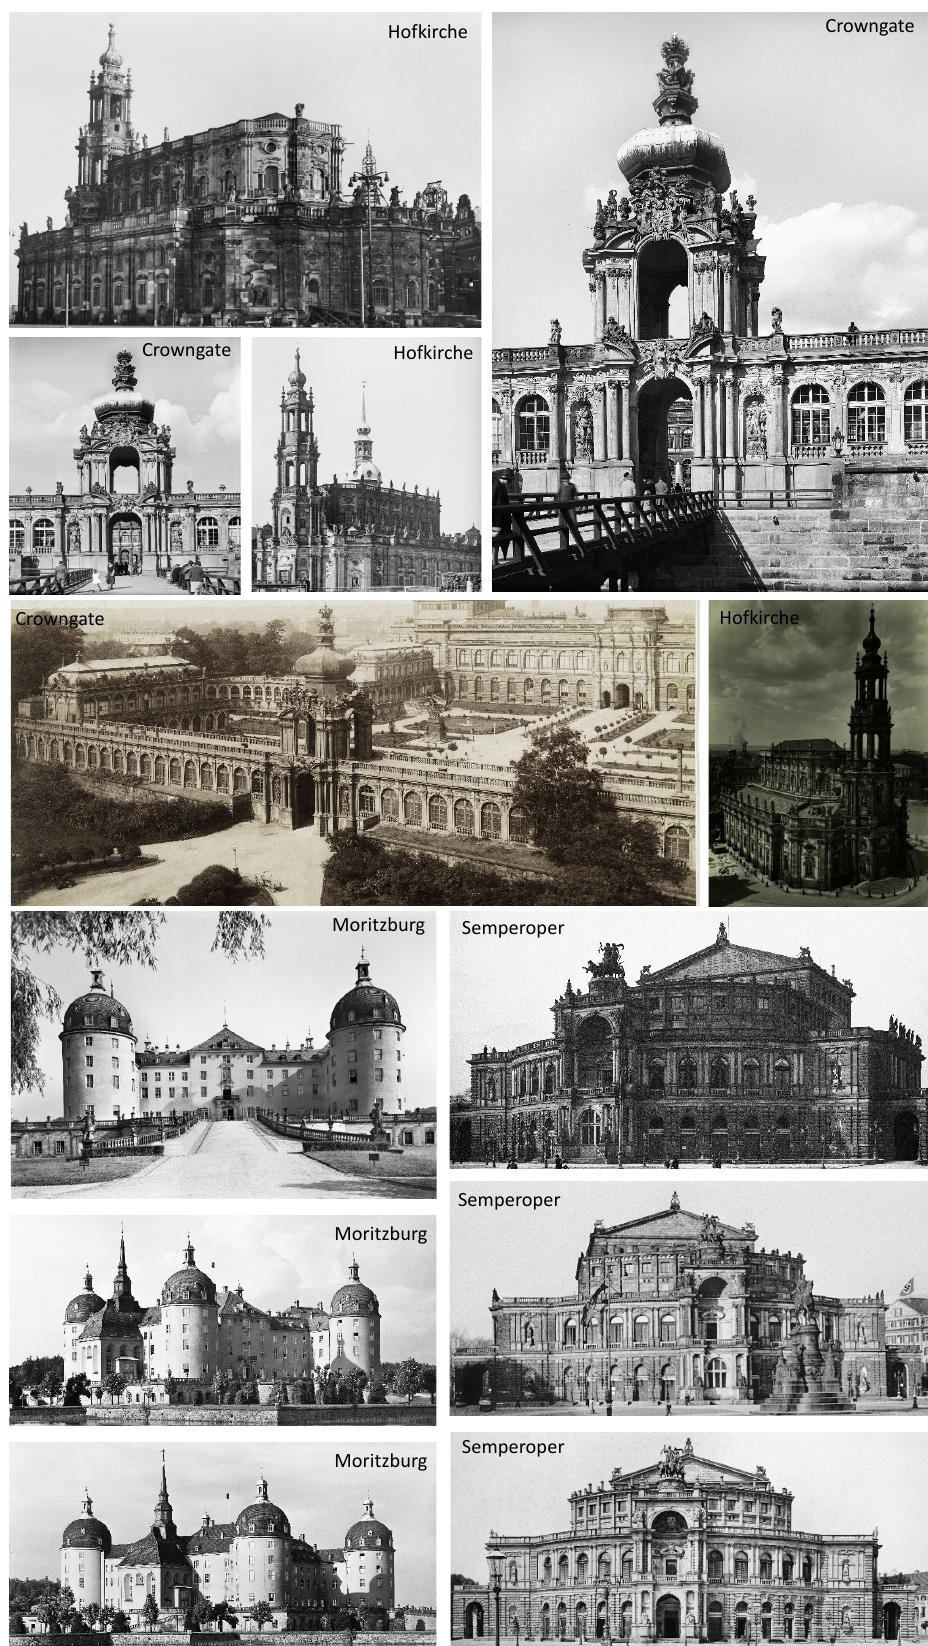
Figure 3. All query images used for automatic selection of retrieval datasets using LEA